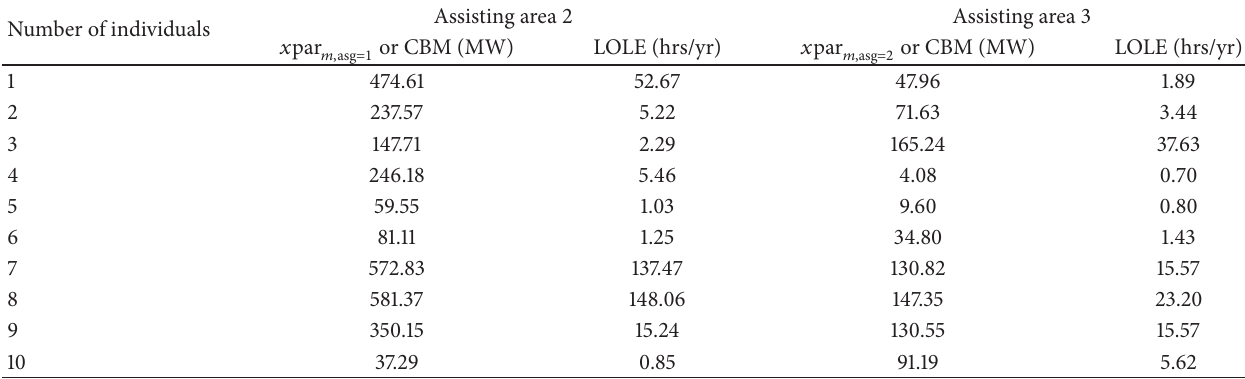
Table 3: Initial population of EP technique for the assisting areas 2 and 3.